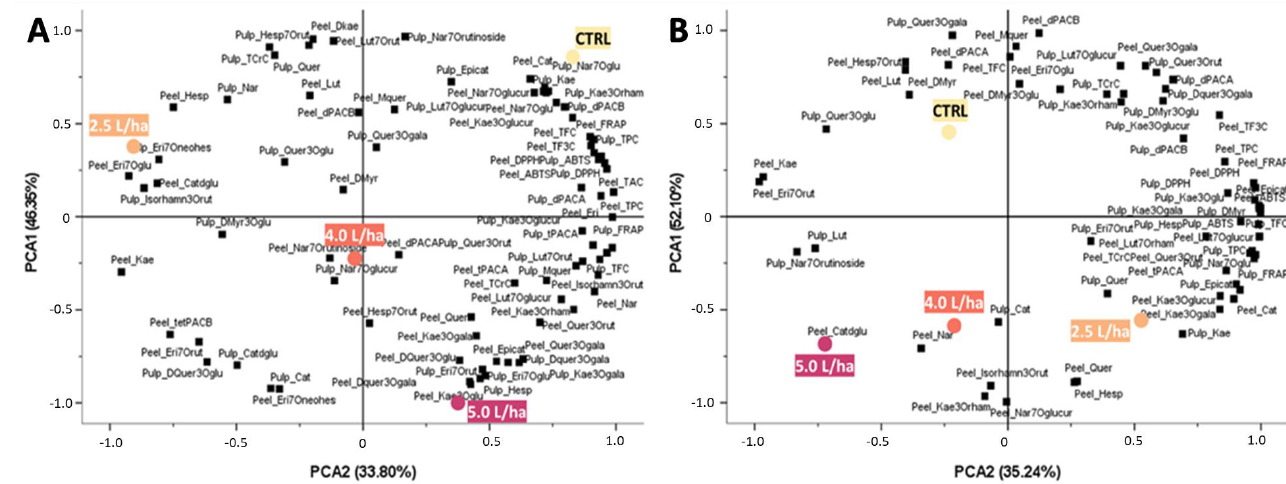
Figure 7. Scatter plot of the principal component (PC1 and PC2) factor scores calculated on the PCA of the phytochemical compounds of the peaches harvested from Prunus persica trees var. “Sugar Time” ( A ) or “West Rose” ( B ) treated with different biostimulant concentrations (5.0, 4.0 or 2.5 L/ha) or with water alone. In the different panels, CTRL identifies samples harvested from trees treated with water only. The PCAs were obtained using data relative to both the peel and pulp included and listed in Tables 2 and 3. Black squares report the distribution of the individual compounds identified via HPLC-ESI-MS/MS analysis. Data used for plotting are reported in Supplementary Materials Table S1 (var. “ Sugar Time ” ) and Supplementary Materials Table S2 (var. “ West Rose ” ).